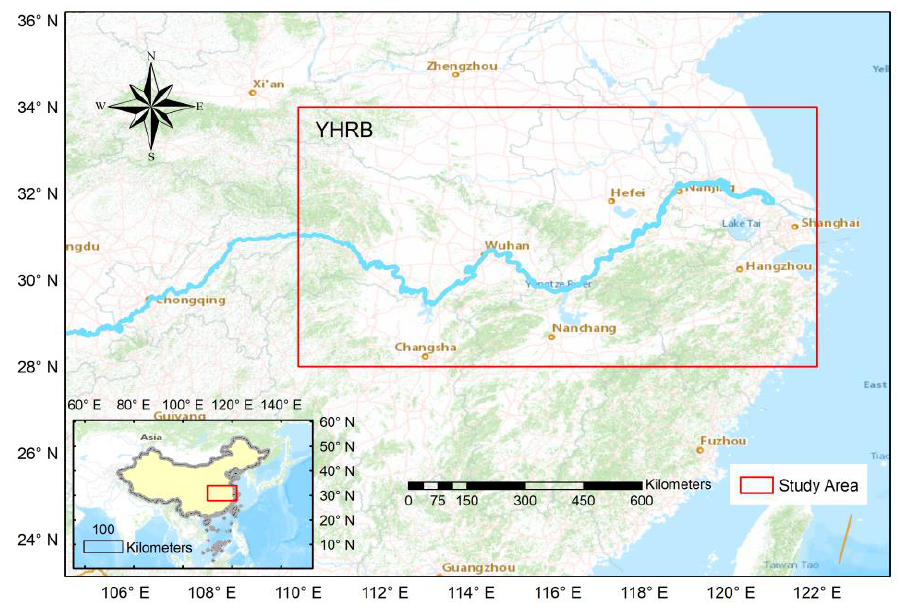
Figure 1. Study area of the YHRB denoted by the land portion in the red box.